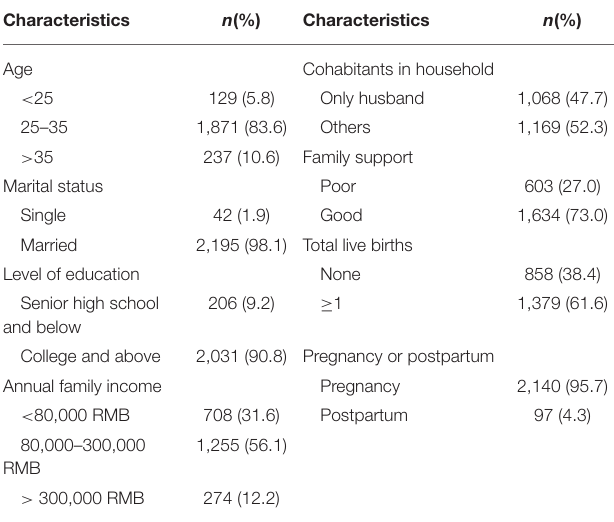
TABLE 1 | Sociodemographic and obstetric characteristics in the whole sample.